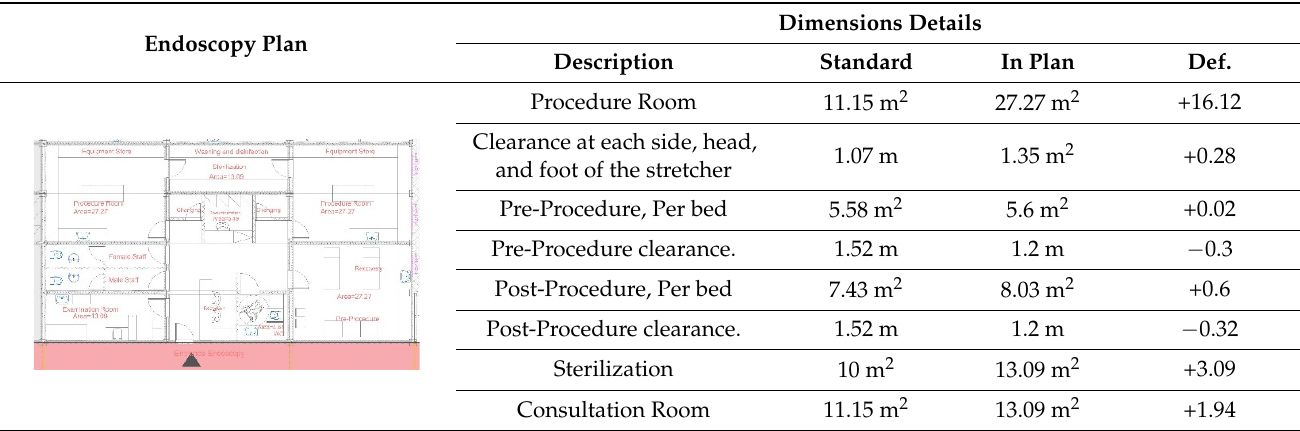
Table 7. Dimensional requirements of the endoscopy department compared to standards.